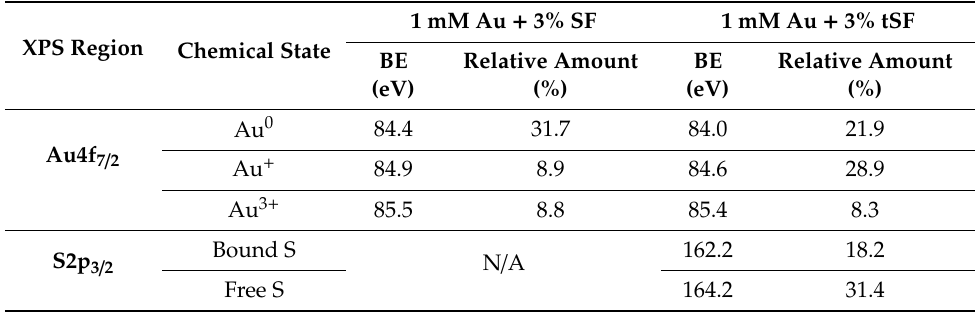
Table 1. Relative percentage of chemical composition determined from XPS spectra within Au4f 7 / 2 and S2p region of the lyophilized 1 mM Au 3 + with 3% SF or 3% tSF samples. Peaks areas of the di ff erent chemical states were calculated using Origin Pro 9.0 software.